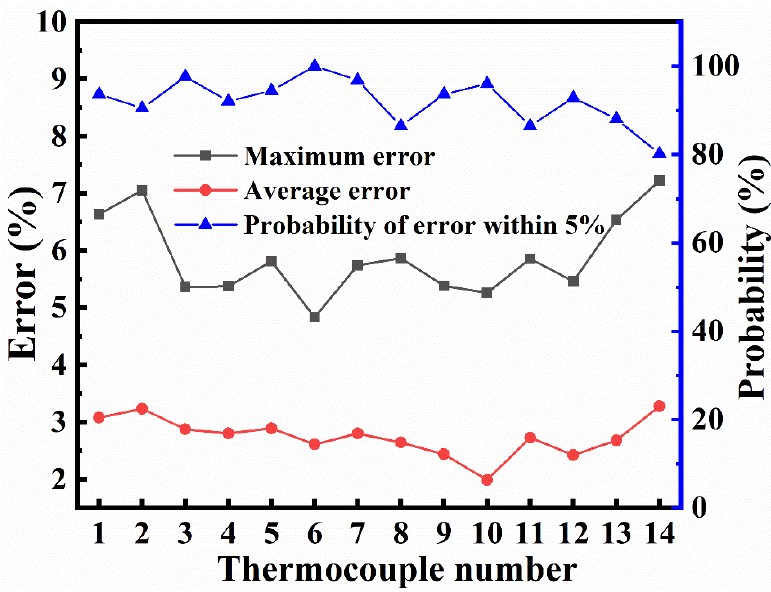
Figure 10. Simulation error distribution.